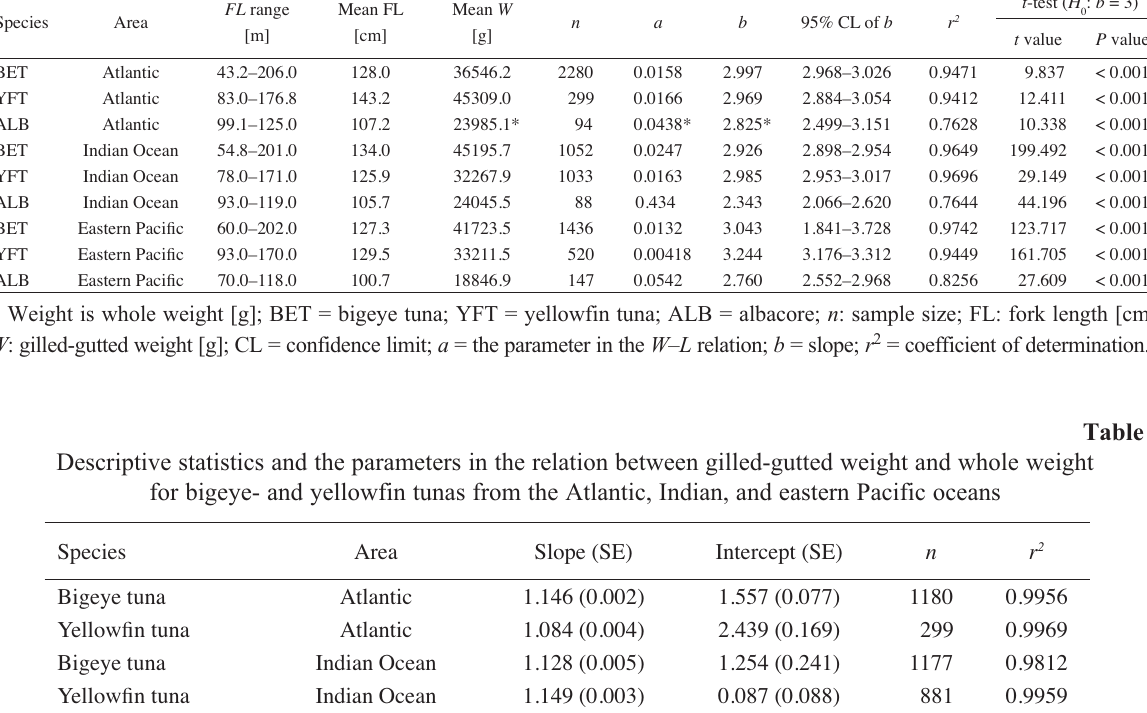
Descriptive statistics and Length–weight relation parameters for bigeye tuna, yellowfin tuna, and albacore from the Atlantic, Indian, and eastern Pacific oceans